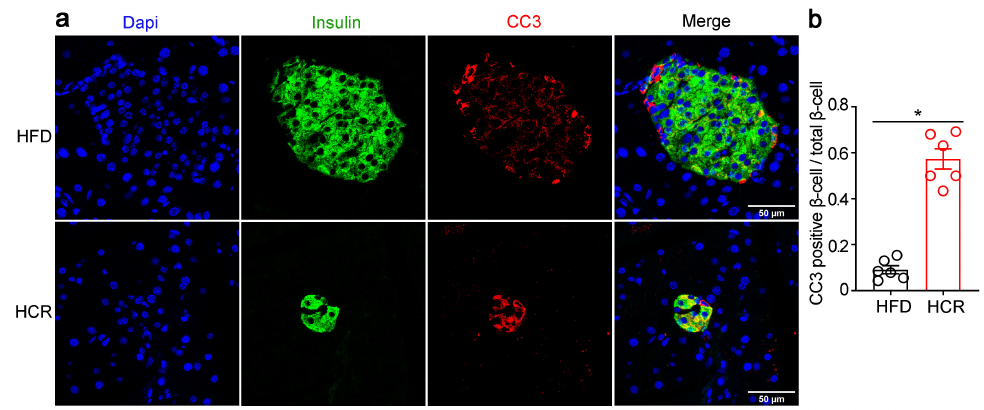
Figure 5. CR induced islet β -cell apoptosis in diabetic mice. ( a ) Representative immunofluorescence images of cleaved caspase-3 (CC3, red) and insulin (green). ( b ) Quantification of CC3-positive β -cells/total β -cells. The results were expressed as mean values ± SEM. ( n = 6 per group), * p < 0.05 vs. HFD mice.